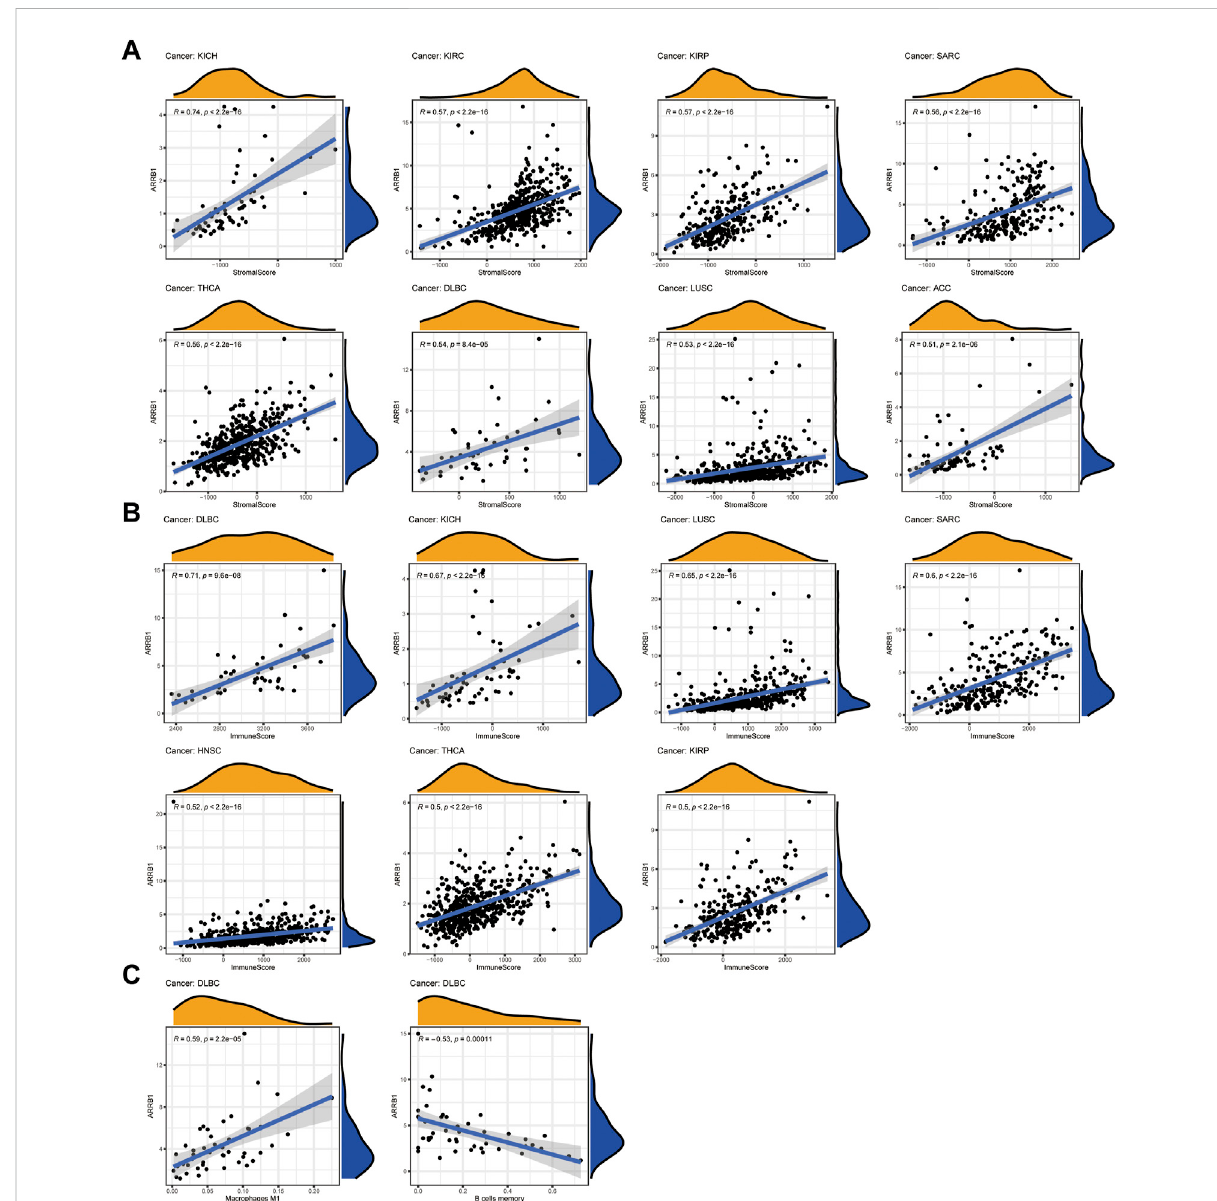
FIGURE 5 Correlation between ARRB1 expression and ESTIMATE score and immune cell in fi ltration. (A) Correlation between ARRB1 expression and stromal cell score in tumor tissue; (B) Correlation between ARRB1 expression and immune cell score in tumor tissue; (C) Correlation between ARRB1 expression and immune cell in fi ltration. Only correlation plots with correlation coef fi cients R > 0.5 and p < 0.001 are